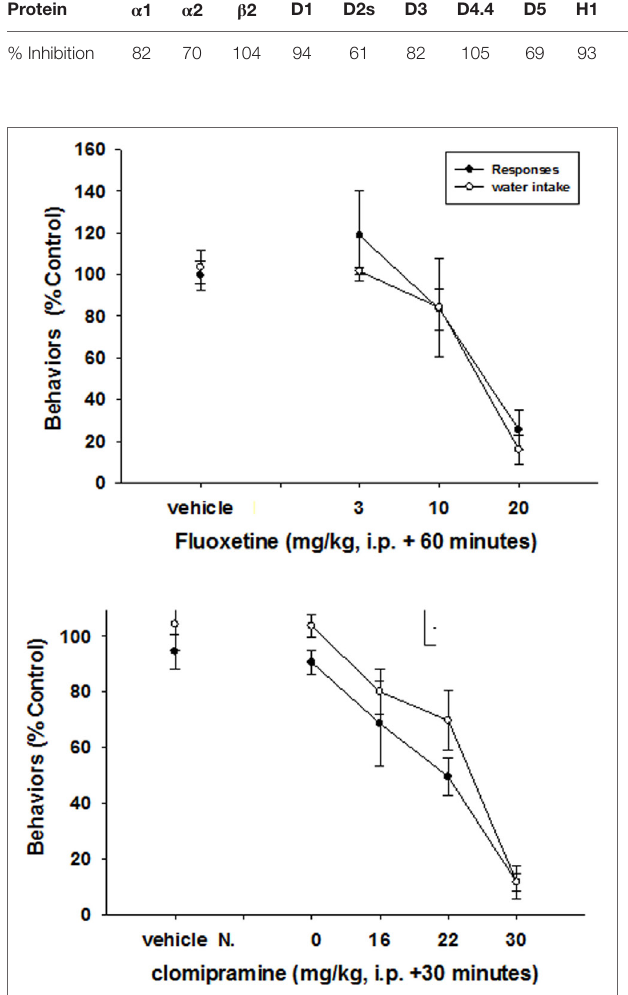
FigUre 2 | effects of ssris on schedule-induced polydipsia . Significant effects on the number of responses and amount of water consumed were produced by both fluoxetine ( F 2,23 = 4.4, p < 0.001— responses; F 2,23 = 25, p < 0.0001—water) and clomipriamine ( F 3,31 = 12.6, p < 0.0001—responses; F 3,31 = 20.5, p < 0.0001). Each point represents the mean ± SEM of eight rats.